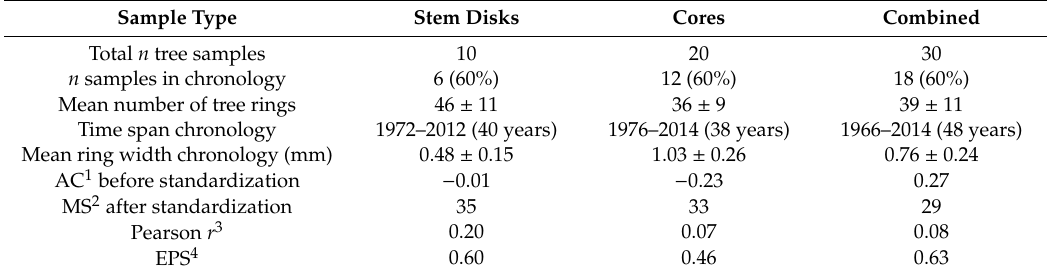
Table 2. Characteristics of the Erica chronologies for the stem disks, tree cores, and combined